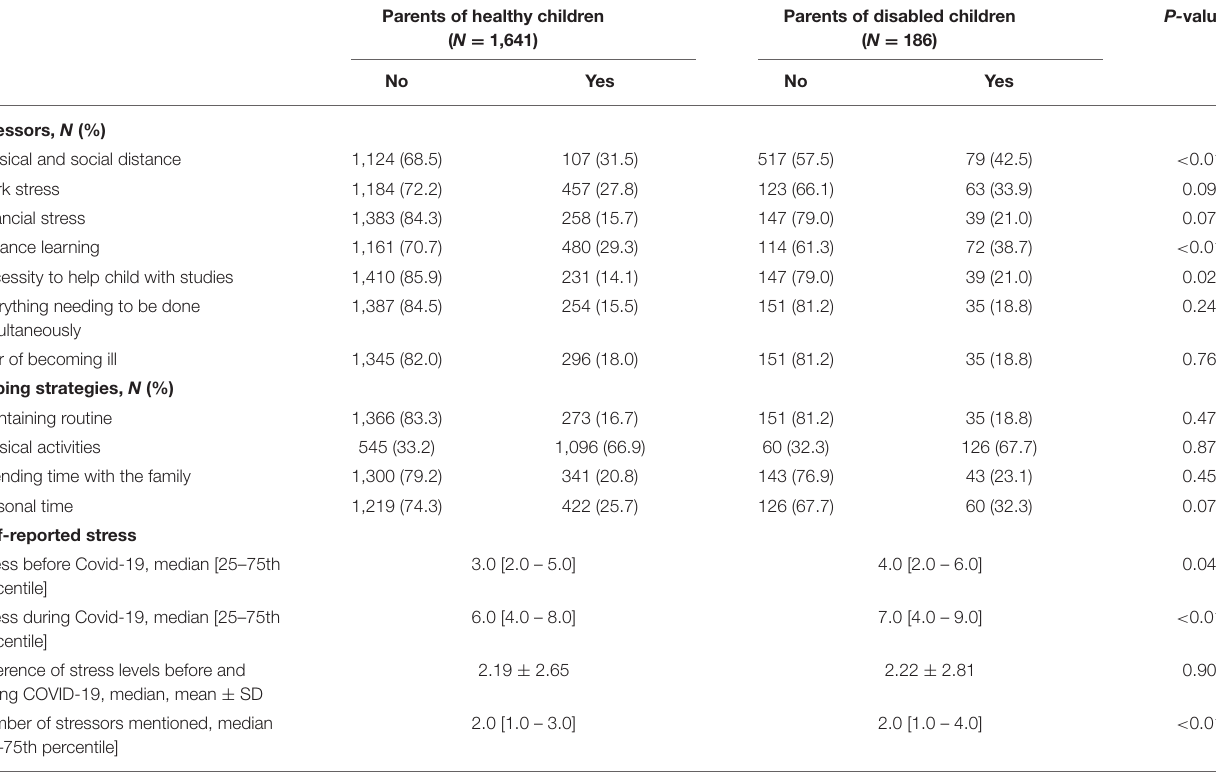
TABLE 2 | Stressors and coping strategies of parents with and without children with developmental disorders or chronic conditions during the COVID-19 pandemic first emergency situation in May-June 2020, by group.